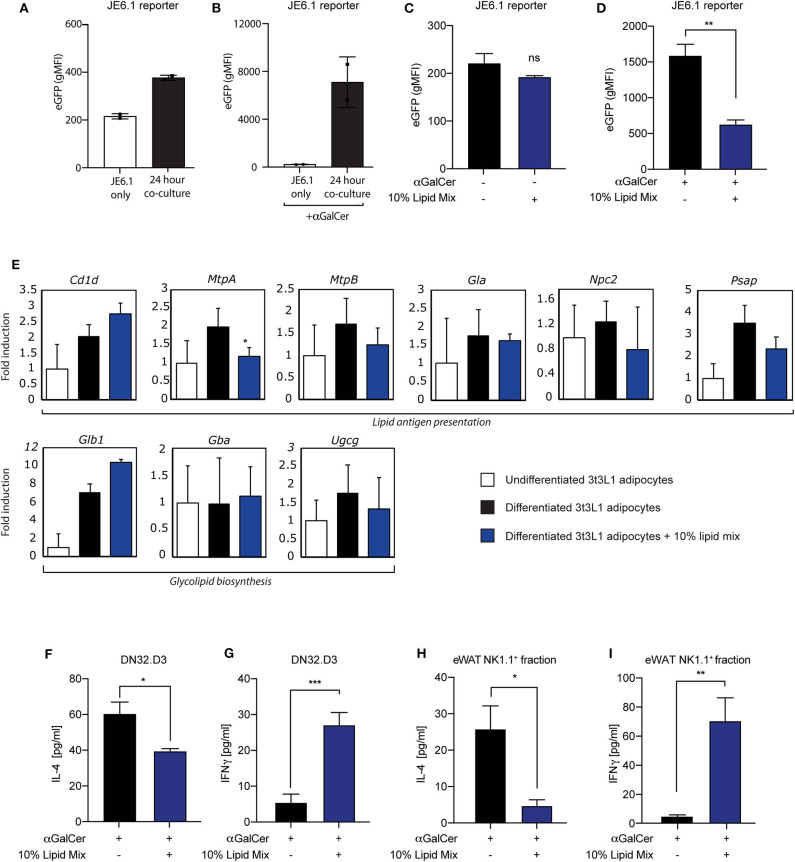
Lipid mixture treatment skews iNKT cell cytokine secretion toward a pro-inflammatory profile after co-culture. (A,B) Co-culture between JE6-1REP−iNKT−β2M_KO reporter cells and mature 3T3-L1 adipocytes stimulated with (B) or without (A) αGalCer (0.5 μg/ml) 24 h prior to co-culture (n = 2) Data is presented as geometric Mean Fluorescent Intensity (gMFI). (C,D) Co-culture between JE6-1REP−iNKT−β2M_KO reporter cell (5 × 104 cells per well in a 96 well-format) and mature 3T3-L1 adipocytes treated with or without 10% lipid mix and stimulated with (D) or without (C) αGalCer (0.5 μg/ml). JE6-1REP−iNKT−β2M_KO cells were collected after 24 h co-culture and analyzed for GFP expression by FACS. Data is presented as geometric Mean Fluorescent Intensity (gMFI) +/− SD (n = 3, P = 0.0044). (E) Mouse 3T3-L1 preadipocytes were differentiated into mature adipocytes and treated with 10% lipid mix for 4 days before being subjected to RNA isolations and Quantitative RT PCR. Transcriptional activity of genes involved in adipogenesis, glycolipid biosynthesis, lipid antigen presentation, and lipolysis are depicted as fold induction relative to undifferentiated 3T3-L1 adipocytes. Data is normalized to housekeeping gene 36B4 and presented as mean +/− SD (n = 6). (F,G) ELISA analysis of IL-4 and IFNγ secreted by DN32.D3 cells after 24 h co-culture with mature 3T3-L1 adipocytes treated with or without 10% lipid mix (n = 3, p = 0.0319 and 0.0004 for IL-4 & IFNγ, respectively) Each data point represents 5 × 104 cells. (H) IL-4 secretion following 24 h co-culture of NK1.1 positive ex-vivo fraction extracted from visceral eWAT, cultured with αGalCer stimulated (0.5 μg/ml) mature 3T3-L1 adipocytes treated with and without 10% lipid mix. Each data point represents 5 × 104 cells taken from a pooled population, statistical analysis via Students t-test against (NS P > 0.05, *P < 0.05, **P < 0.01, ***P < 0.001) (n = 3) (I) IFNγ secretion following 24 h co-culture of NK1.1 positive ex-vivo fraction extracted from eWAT, cultured with αGalCer stimulated (0.5 μg/ml) mature 3T3-L1 adipocytes treated with and without 10% lipid mixture. Each data point represents 5 × 104 cells taken from a pooled population. Statistical analysis via Students t-test against (NS P > 0.05, *P < 0.05, **P < 0.01, ***P < 0.001) (n = 3–6).